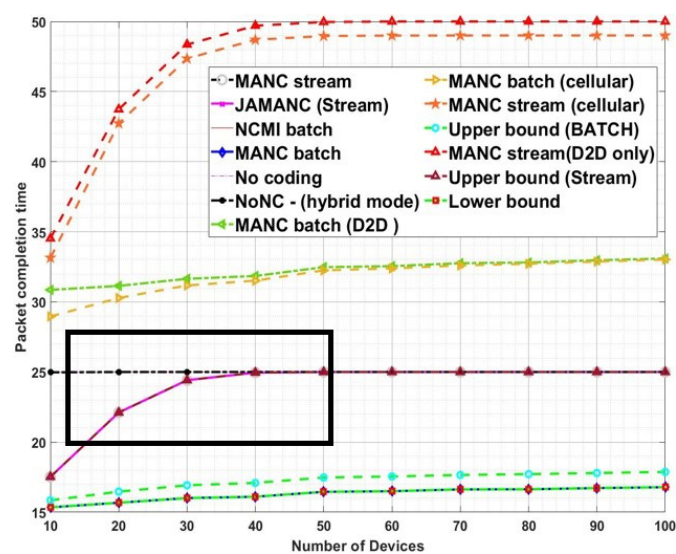
Figure 10. No. of devices vs. completion time (lossless second stage).